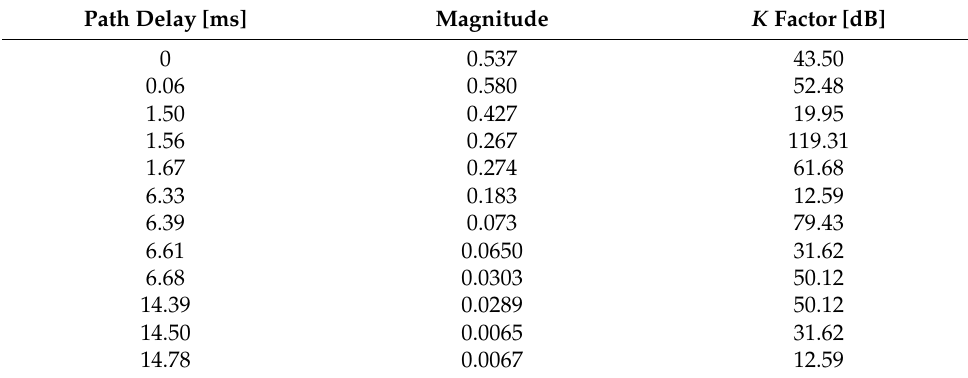
Figure 8. Top view of a typical UWAC system with 3 UWBSs. Table 3. Multipath channel generated by Bellhop channel